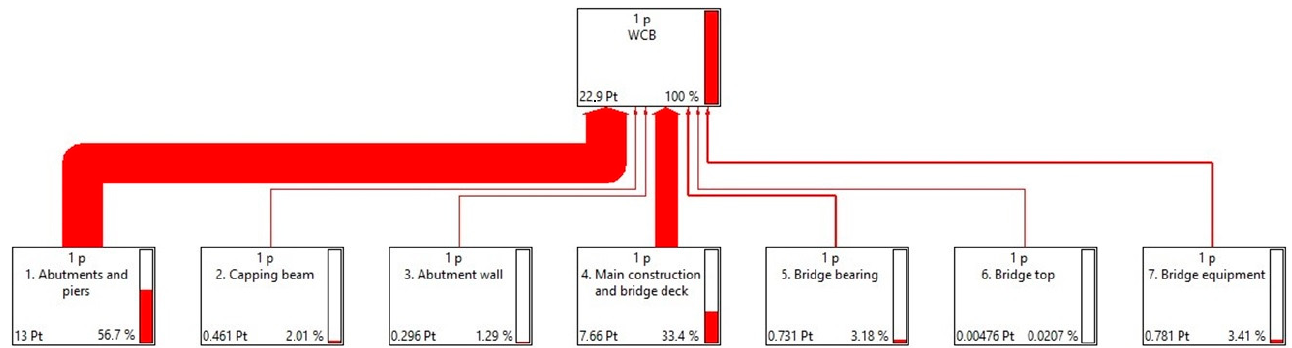
Figure 7. WCB structural damage tree (SimaPro, IMPACT 2002+).